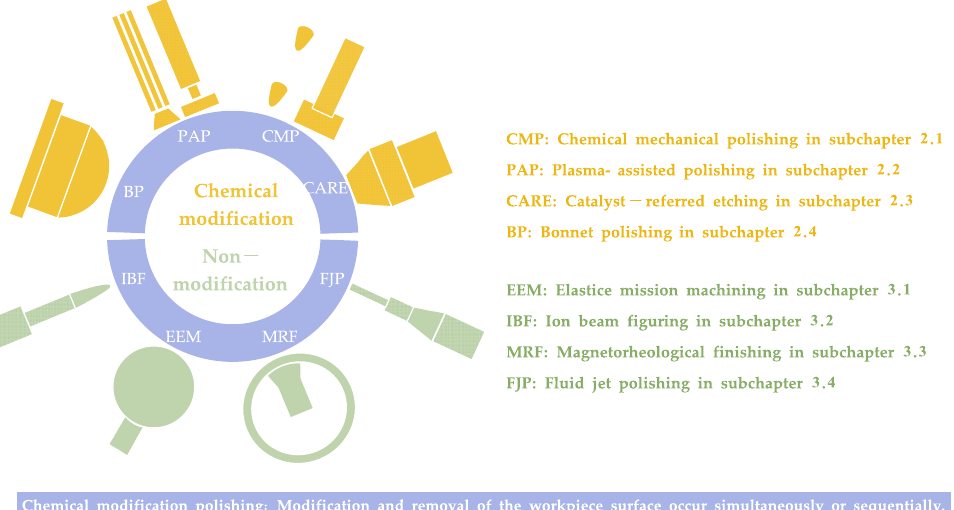
Figure 3. The classification of polishing approaches at